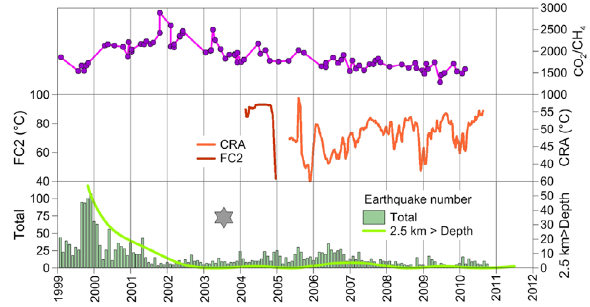
Figure 6. Synthesis of the main results in the period 1999-2011. From top to bottom: time variation of CO /CH ratio (data from 2 4 Caliro et al. [2011], purple circled line), FC2 temperature (1 month running average, ruby red thick line) and CRA temperature (1 month running average, orange thick line), number of total local- izable VT (green bars) and number of events with hypocenters deeper than 2.5 km (acid green thick line). The gray star at the bot- tom identifies the July 20, 2003, Long Period seismic